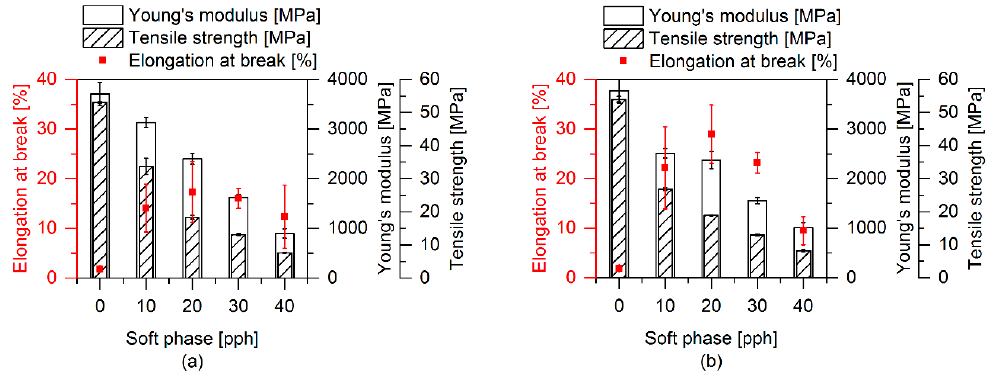
Figure 10. Tensile properties with varying ratios of soft phase. All samples contain 5 pph EMAGMA and 20 wt % SBO inside the soft phase. ( a ) Samples without TBEC and ( b ) samples containing 1 phr TBEC (with reference to soft phase).